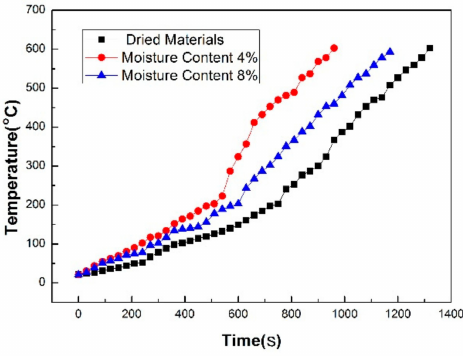
Figure 6. Heating rate curves of NCS with power of 1000 W at di ff erent moisture